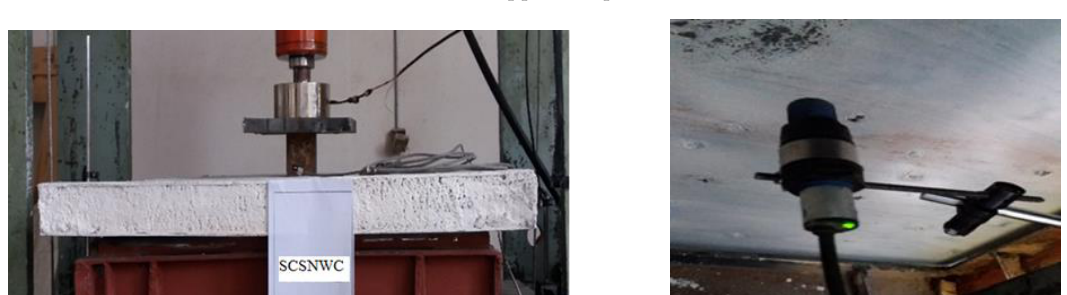
Figure 11. Deformation of the bottom and top plate. One of the main disadvantages of SCS slabs with NWC core is the impossibility of using them in marine structures such as ship-hull due to high weight. So, for this reason, this study was focused on reducing the weight of the SCS slab by using LWC. In Figure 12, the load-displacement curve of the different specimens was shown.